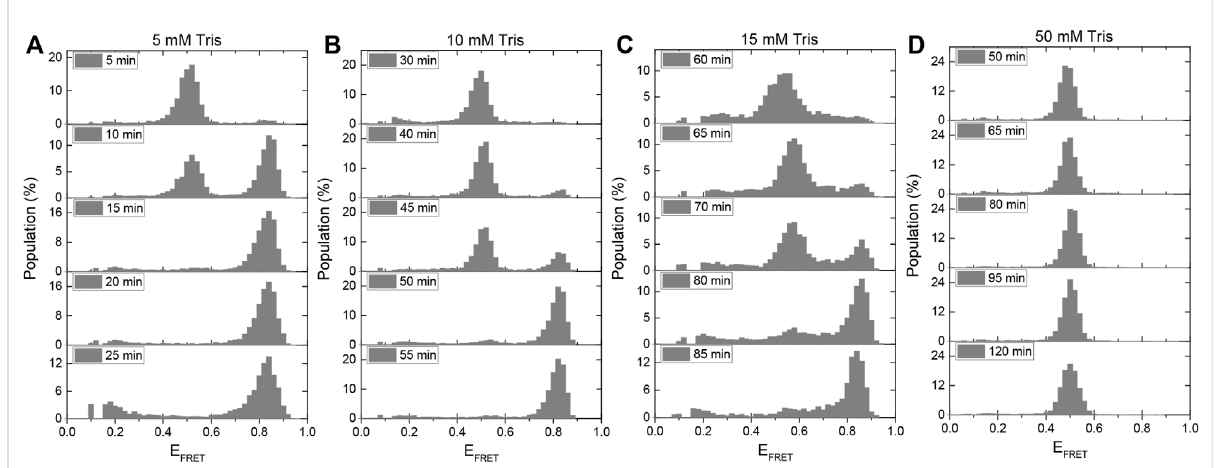
FIGURE 5 A method for using the i-motif as an in-situ pH sensor in smFRET experiments has been developed. When gloxy is used as the oxygen scavenging system, the gradual acidi fi cation of the environment is quanti fi ed for (A) 5 mM Tris, (B) 10 mM Tris, (C) 15 mM Tris, and (D) 50 mM Tris. The amount of time required for the pH to drop from 7.5 to 6.5, atwhichpoint i-motif folding begins, increases as the buffer strength is increased. In the presence of 50 mM Tris, all of the DNA molecules remain unfolded for the entire 120-min imaging